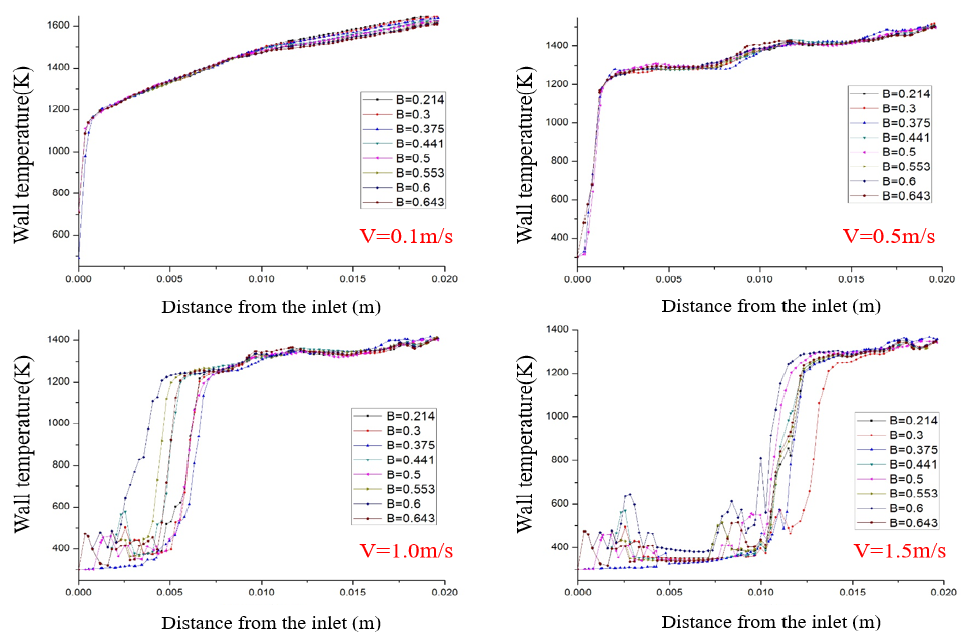
Figure 8. The axial wall temperature at different